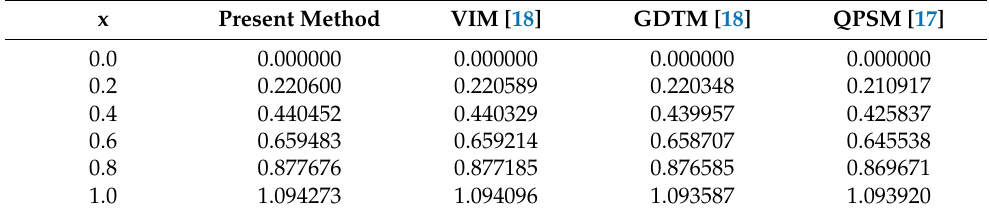
Table 1. The comparison between the proposed method and other existing methods for t = 0.1 and various x values. x Present Method VIM